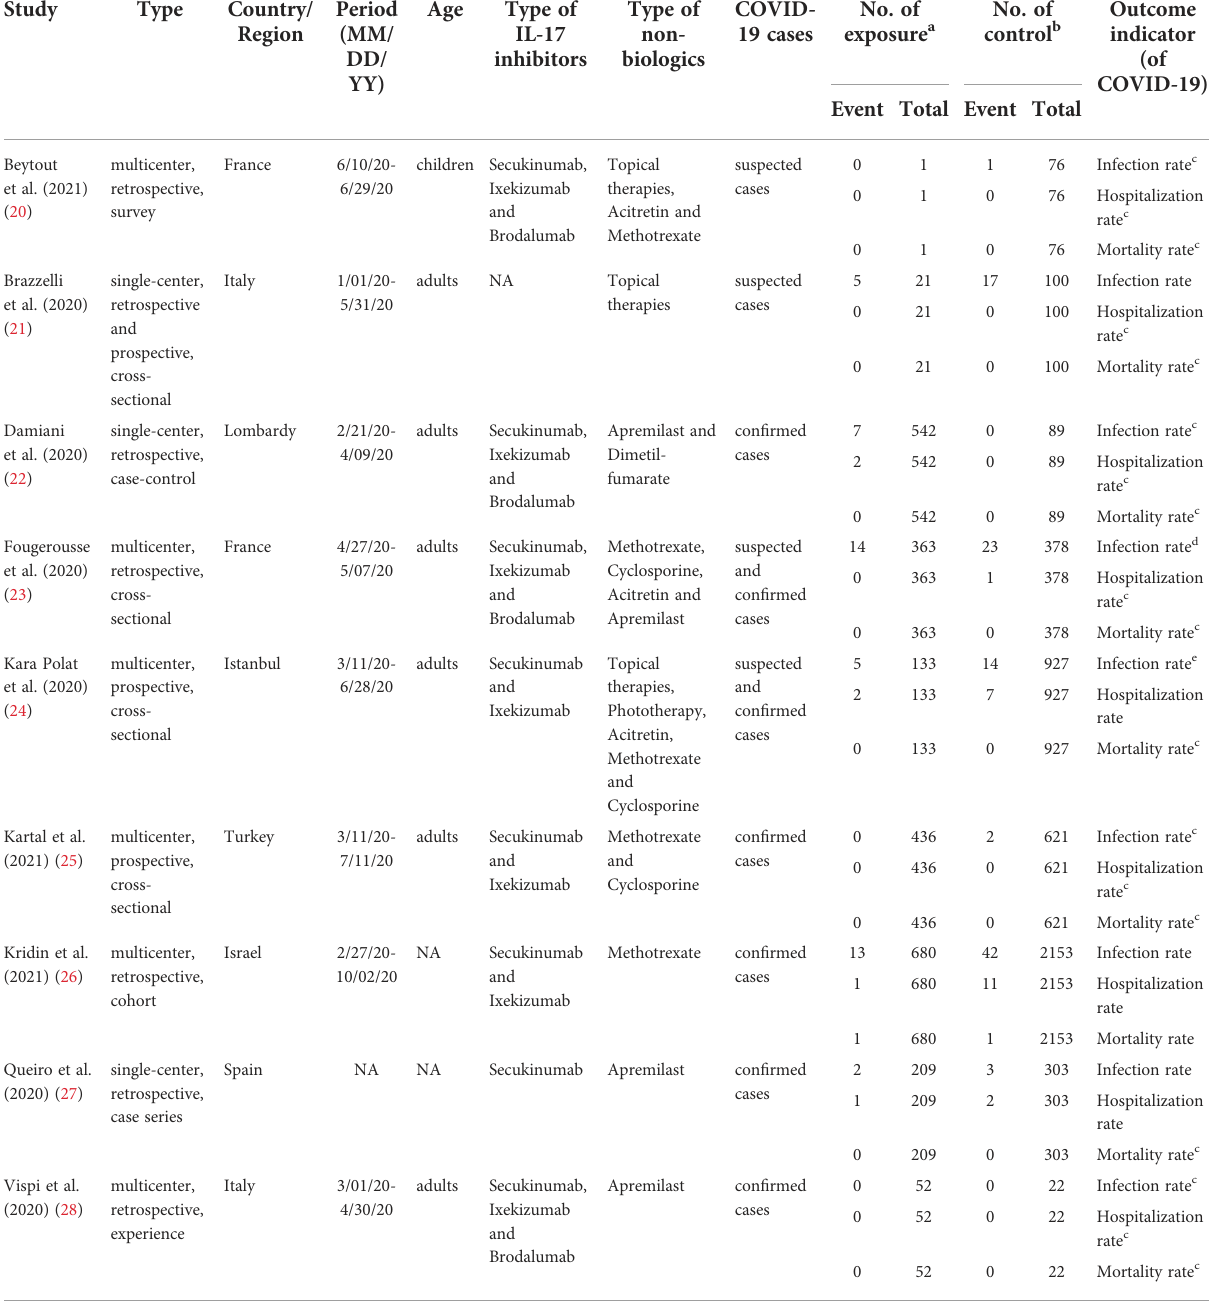
TABLE 1 Baseline Characteristics of Studies Included in the